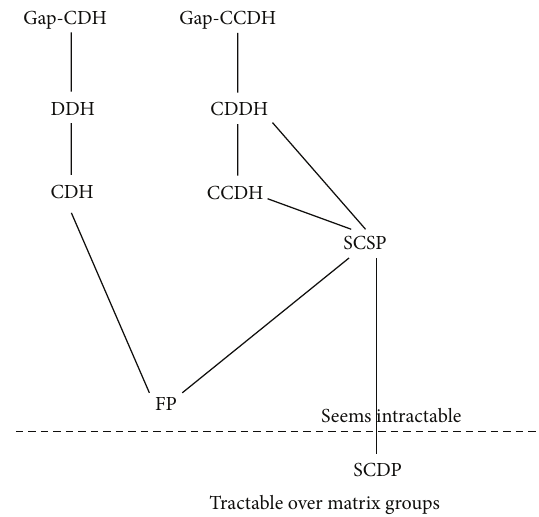
Figure 1: Cryptographic problems over nonabelian